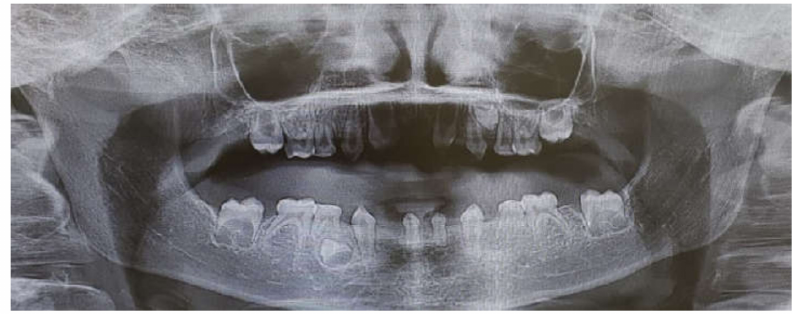
Figure 2. Panoramic pre-operative